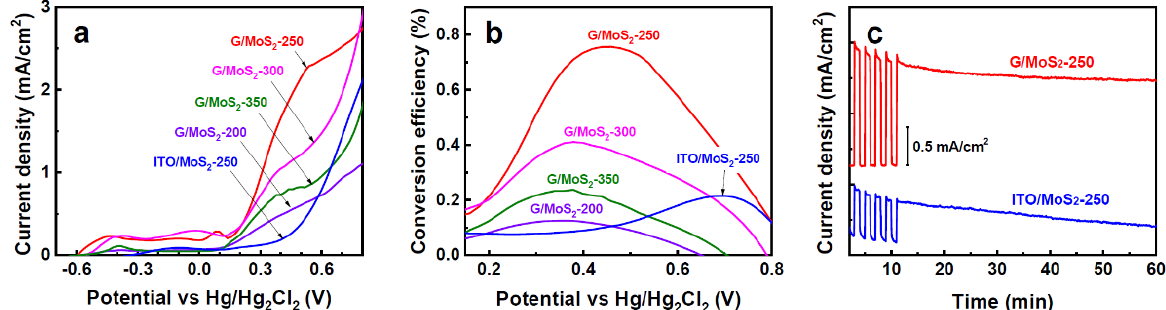
Figure 4. ( a ) Photocurrent density–potential curves and ( b ) photoconversion efficiency–potential curves of PEC cells with various working electrodes (ITO/MoS 2 -250, G/MoS 2 -200, G/MoS 2 -250, G/MoS 2 -300, and G/MoS 2 -350). ( c ) Photocurrent–time plots for ITO/MoS 2 -250 and G/MoS 2 -250 at 0.6 V.